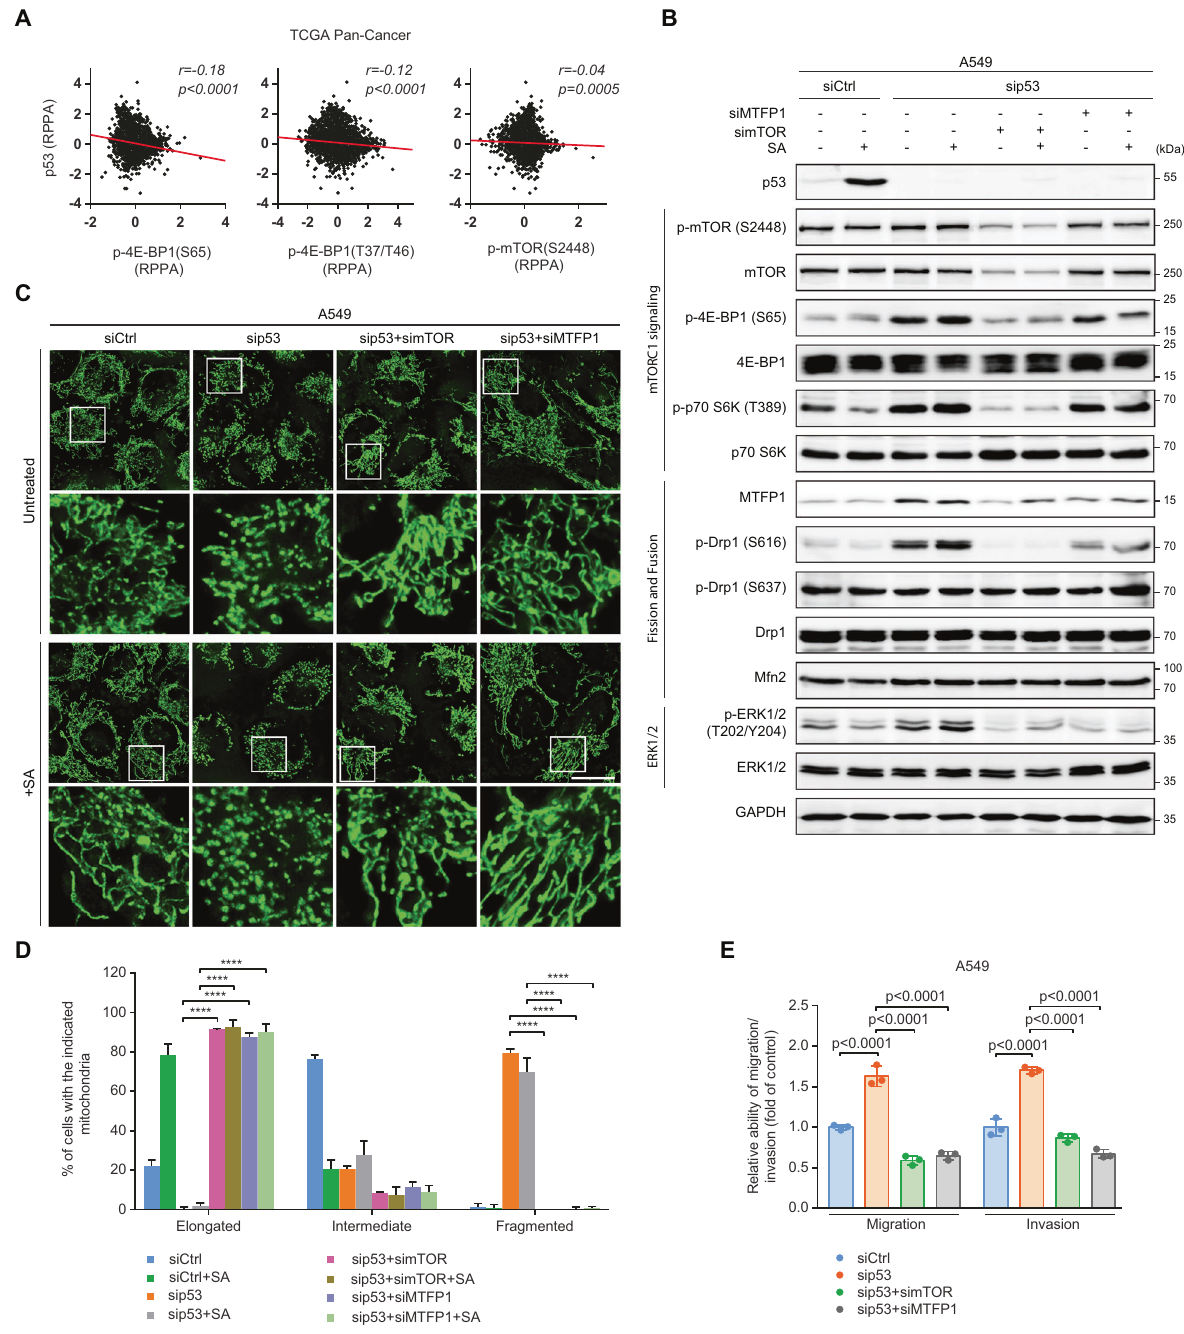
Fig. 5 p53 diminishes mTORC1-controlled MTFP1 protein levels to attenuate Drp1-driven mitochondrial fi ssion and invasive cell migration. A Correlations between the RPPA levels of p53 and the indicated proteins ( n = 7694 samples). Data were extracted from TCGA. B Immunoblot of the indicated proteins in siCtrl, sip53, p53/mTOR double-knockdown (sip53 + simTOR), and p53/MTFP1 double-knockdown (sip53 + siMTFP1) A549 cells with and without 20 µM SA treatment for 24 h. GAPDH was used as a loading control. Representative images ( C ) and quanti fi cation ( D ) of mitochondrial morphology in siCtrl ( n = 203), siCtrl + SA ( n = 207), sip53 ( n = 200), sip53 + SA ( n = 213), sip53 + simTOR ( n = 234), sip53 + simTOR + SA ( n = 209), sip53 + siMTFP1 ( n = 214), and sip53 + siMTFP1 + SA ( n = 213) A549 cells. Boxed regions in ( C ) are shown enlarged in the bottom panels of each group. Scale bar: 20 µm. E Transwell assays for siCtrl, sip53, sip53 + simTOR, and sip53 + siMTFP1 A549 cells. Error bars represent mean ± SD. Data were analyzed by one-way ANOVA with Tukey ’ s multiple comparisons test. ****p < phosphorylations of Drp1 and 4E-BP1 in p53-silenced cells with invasion upon p53 loss. Indeed, we observed that ERK1/2 and without SA-treatment (Fig. 6B). In contrast, similar to phosphorylation displayed inverse and direct correlations with observations seen upon depletion of Drp1, MTFP1, or mTOR, p53 and the phosphorylations of mTORC1-relevant factors (mTOR inhibition of ERK1/2 rescued the aggressive cell phenotype caused and 4E-BP1), respectively (Fig. 6A). Inhibition of ERK1/2 with by p53 silencing (Fig. S5A), diminished the mRNA levels of the PD98059 had no signi fi cant effect on MTFP1 protein levels and the